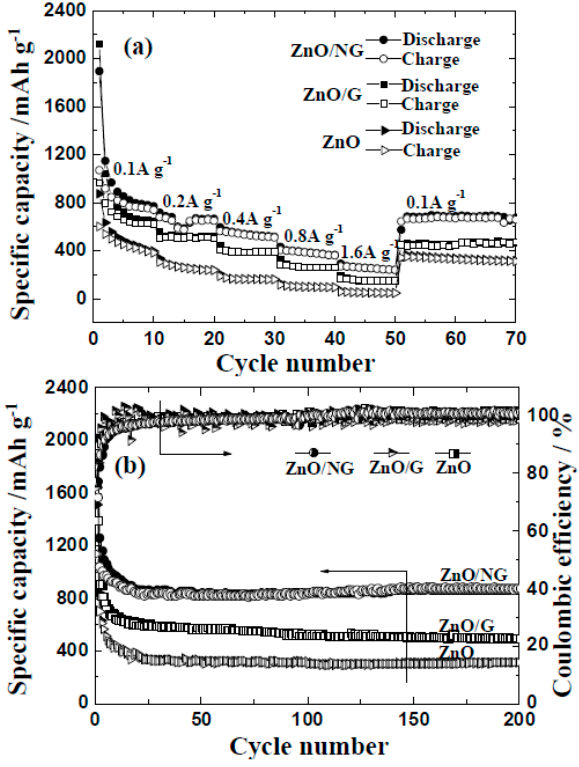
Figure 5. ( a ) Rate capabilities, ( b ) cycle abilities of ZnO, ZnO/G, and ZnO/NG anodes at 100 mA g − 1 .